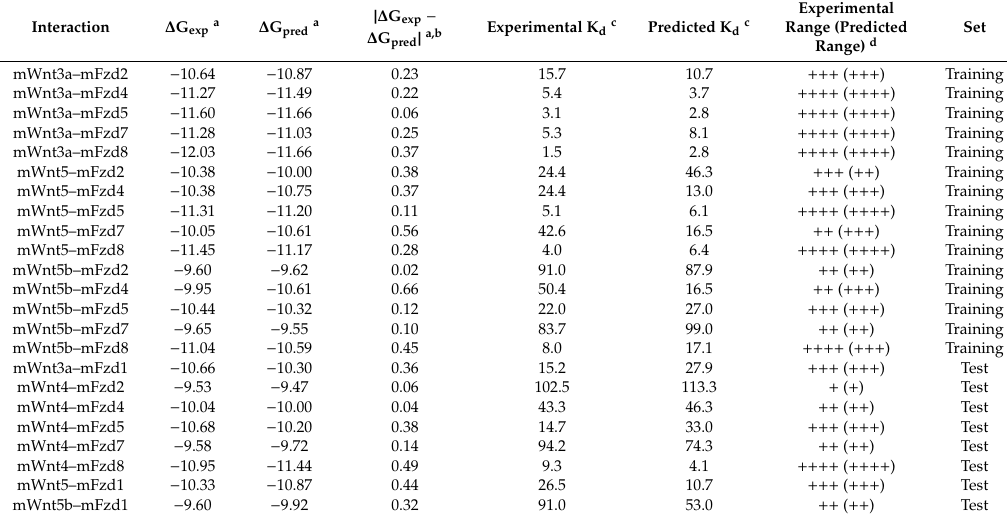
Table 2. Comparison of predictions made by Model 1 with experimental data for the training and test sets.